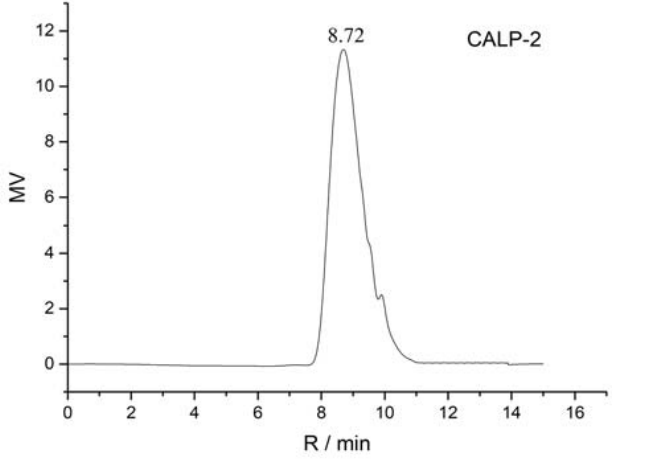
Figure 4. HPGPC profiles of CALP-1.